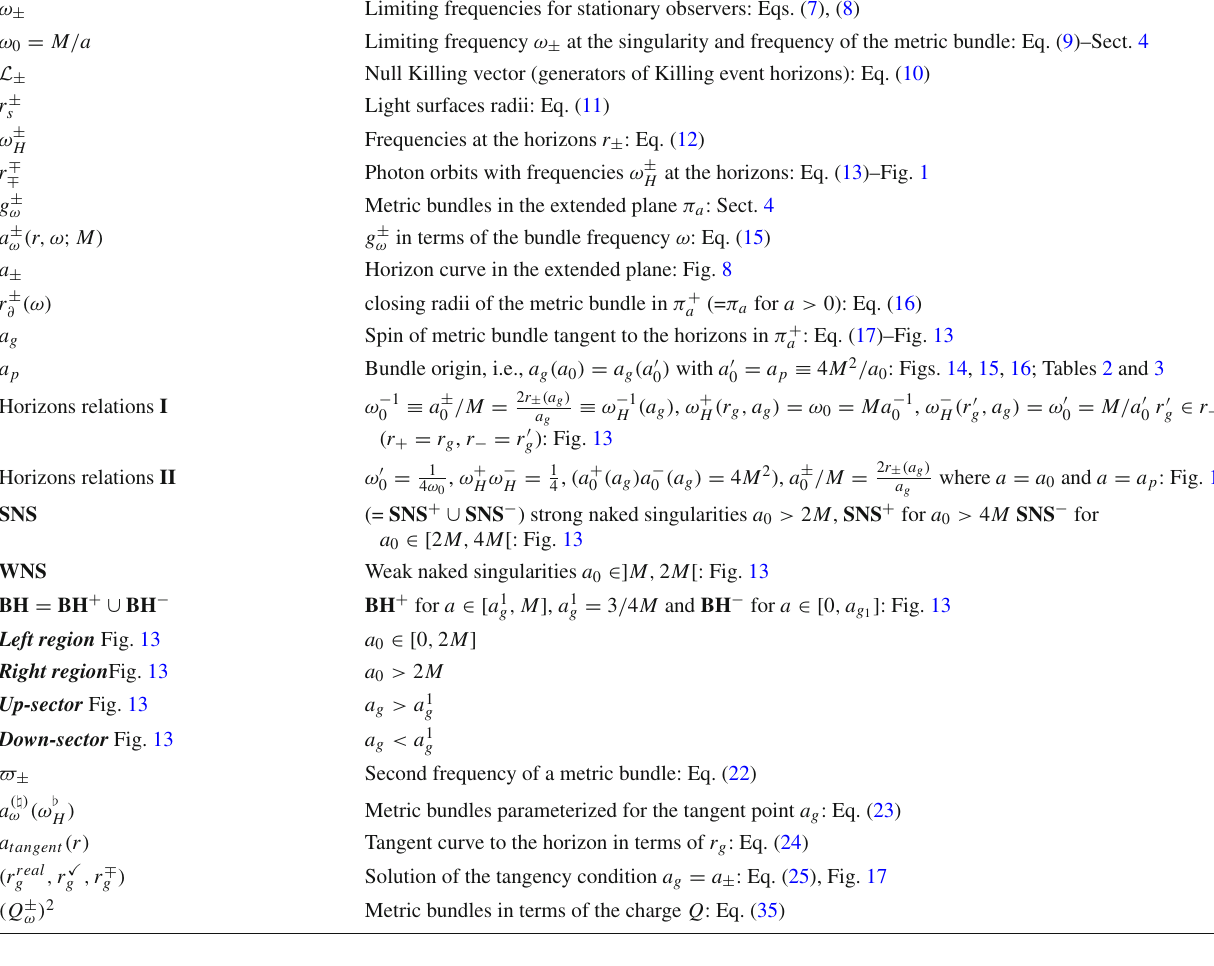
Table 1 Lookup table with the main symbols and relevant notations used throughout the article Limiting frequencies for stationary observers: Eqs. (7), (8) Limiting frequency ω ± at the singularity and frequency of the metric bundle: Eq. (9)–Sect. 4 Null Killing vector (generators of Killing event horizons): Eq. (10) Light surfaces radii: Eq. (11) Frequencies at the horizons r ± : Eq. (12) Photon orbits with frequencies ω ± at the horizons: Eq. (13)–Fig. 1 H Metric bundles in the extended plane π a : Sect. 4 Horizon curve in the extended plane: Fig. 8